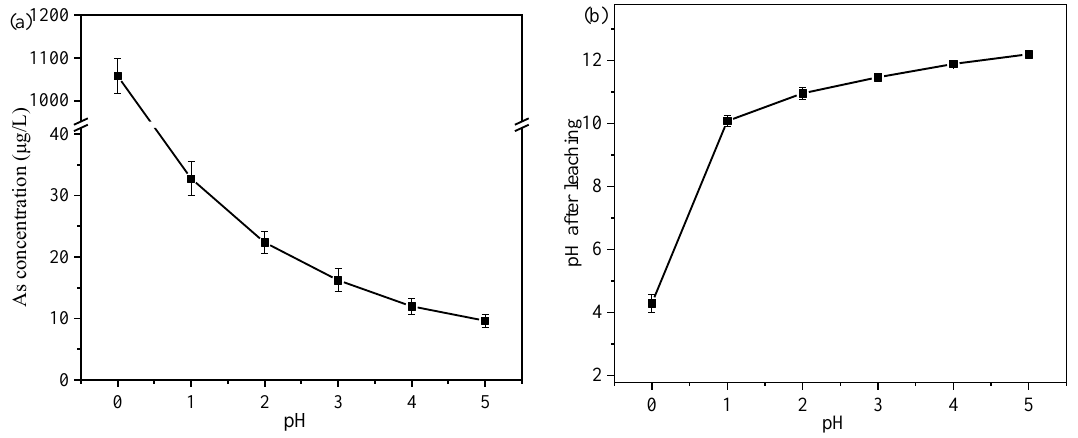
Figure 7. ( a ) The influence of different pH on the leaching concentration of As, ( b ) the change of pH after leaching.